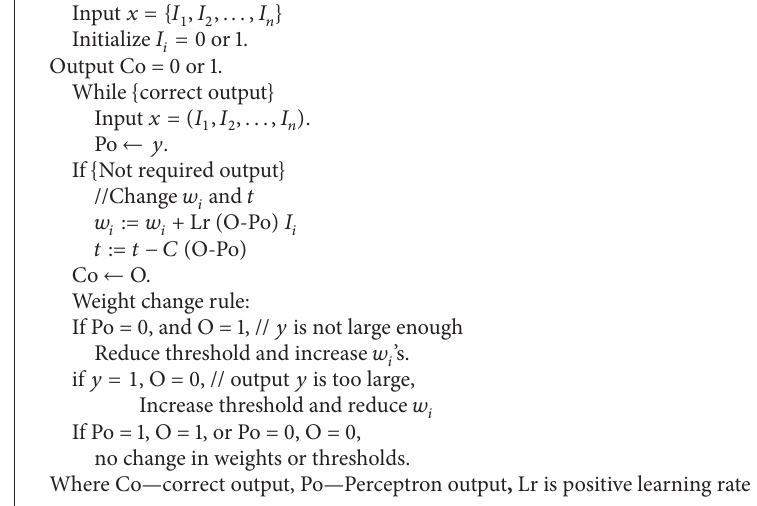
Algorithm 1: Perceptron learning rule.